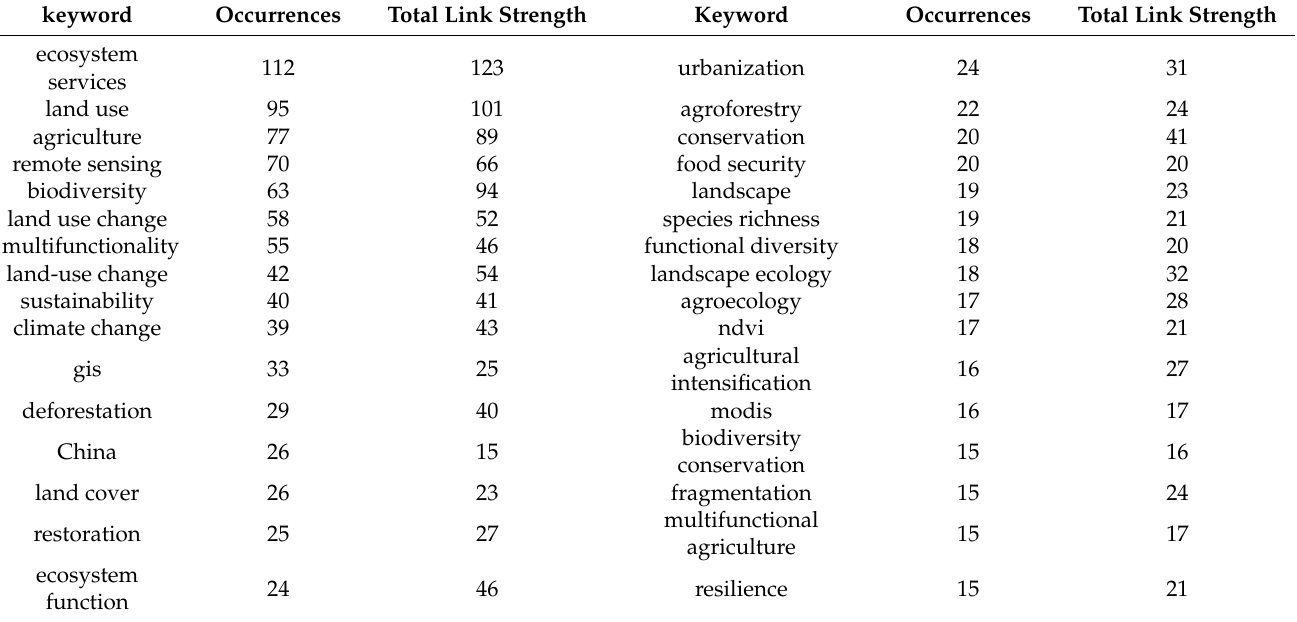
Table 4. The high occurrences of author keywords in agricultural land function from 1991 to 2021.